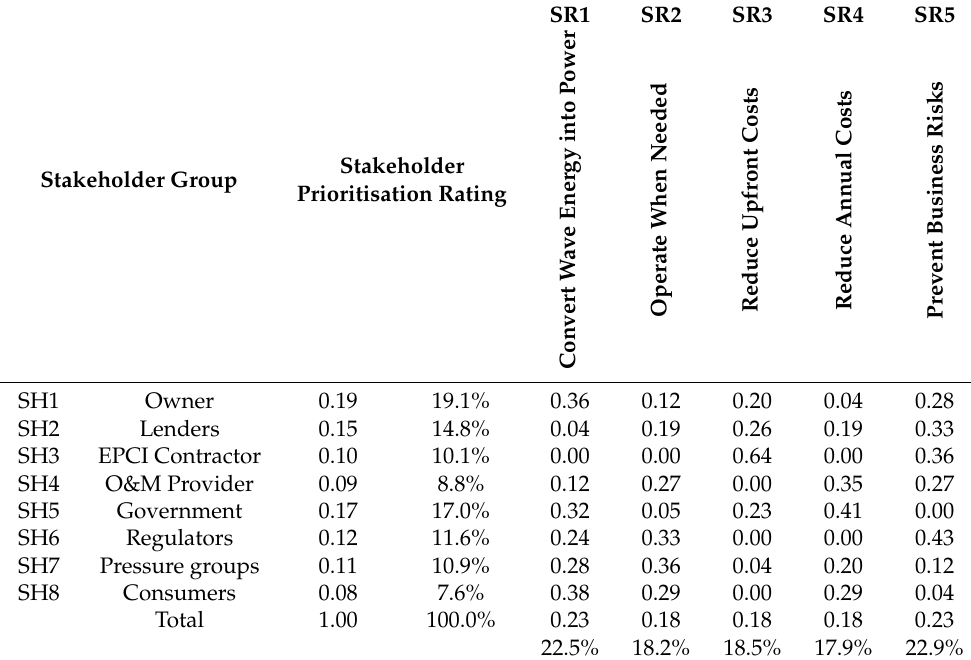
Table A3. Stakeholders (SH) to Stakeholder Requirements (SR) for Utility-scale generation.